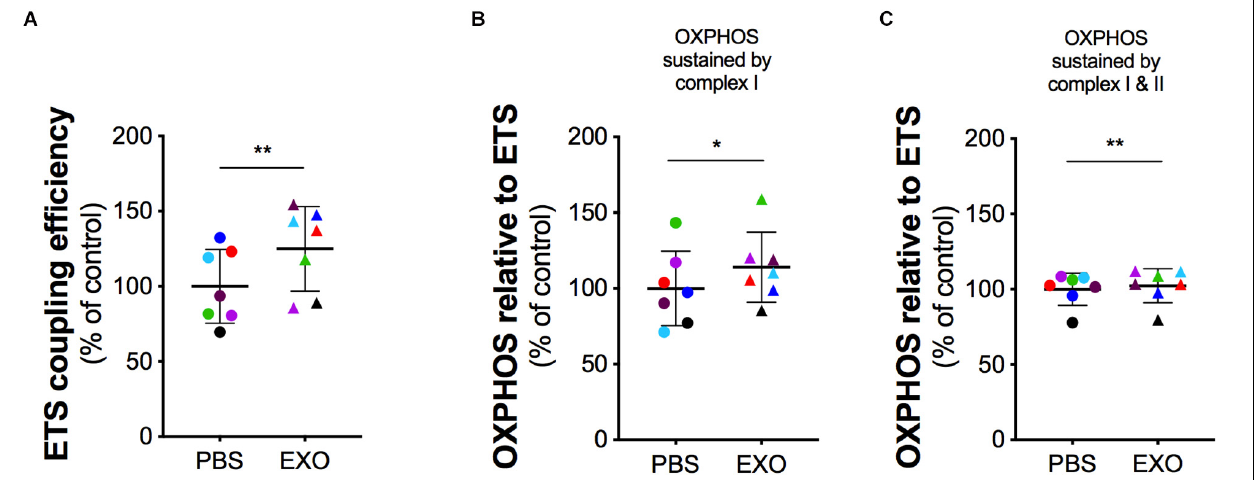
FIGURE 5 | Mitochondrial function in G93ADOXY+ cells after exosomes treatment. Dot plots of data obtained from respirometry experiments, showing the effects of vehicle (PBS), or exosomes (EXO) treatment in DOXY+ cells for all samples. Each dot corresponds to one sample. The line shows the mean with standard deviation. Paired samples are represented by symbols of the same color. (A) ETS coupling efficiency in G93ADOXY+ intact cells following treatment with exosomes (EXO) or PBS. (B) Flux control ratio of the OXPHOS sustained by complex I (PMG) in G93ADOXY+ permeabilized cells following incubation with exosomes (EXO) or PBS. (C) Flux control ratio of the OXPHOS sustained by complex II (PMGS) in G93ADOXY+ permeabilized cells following incubation with exosomes (EXO) or PBS. Comparison of EXO vs. PBS treated G93ADOXY+ cells was performed using paired t -test. Data are represented as percentage of control (PBS). Data of flux control ratios (mean ± SD) in PBS treated cells cells are: (A) ETS coupling efficiency (0.54 ± 0.13), (B) OXPHOS(PMG) (0.29 ± 0.07), and (C) OXPHOS(PMGS) (0.81 ± 0.12). Paired T test ∗ p < 0.05, ∗∗ p < 0.01. n =